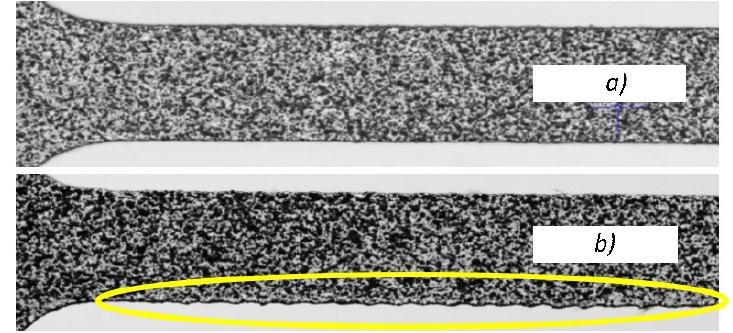
Figure 19. Specimen profile imperfections in the DP1000 ( a ) and the MS1700 ( b ) steels due to waterjet cutting.